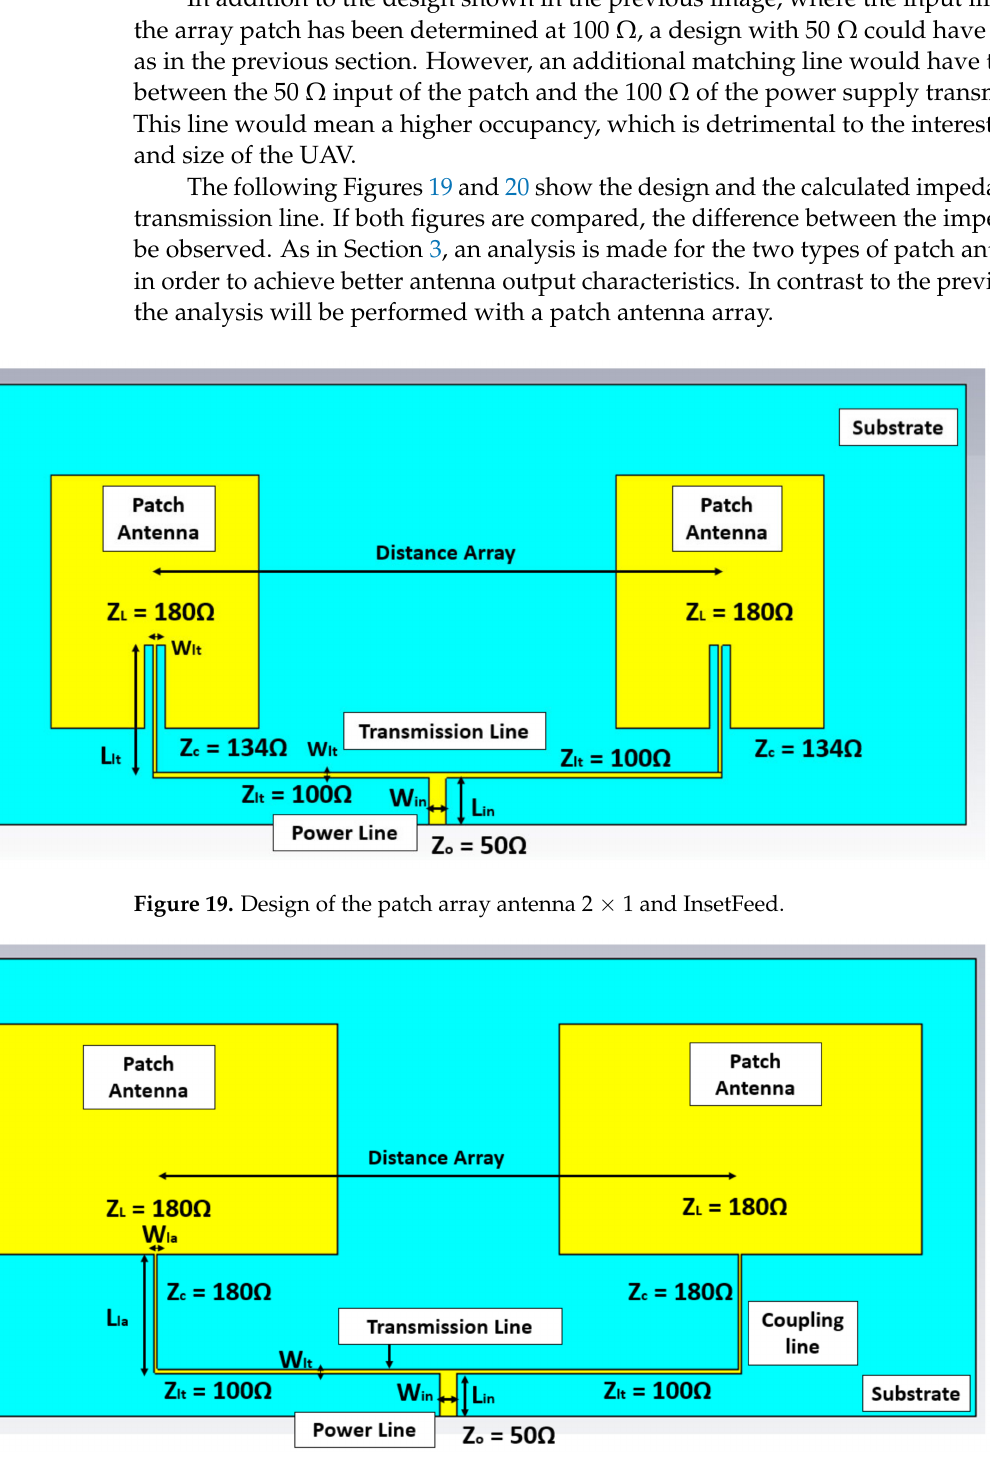
Figure 20. Design of the patch array antenna 2 × 1 and lambda